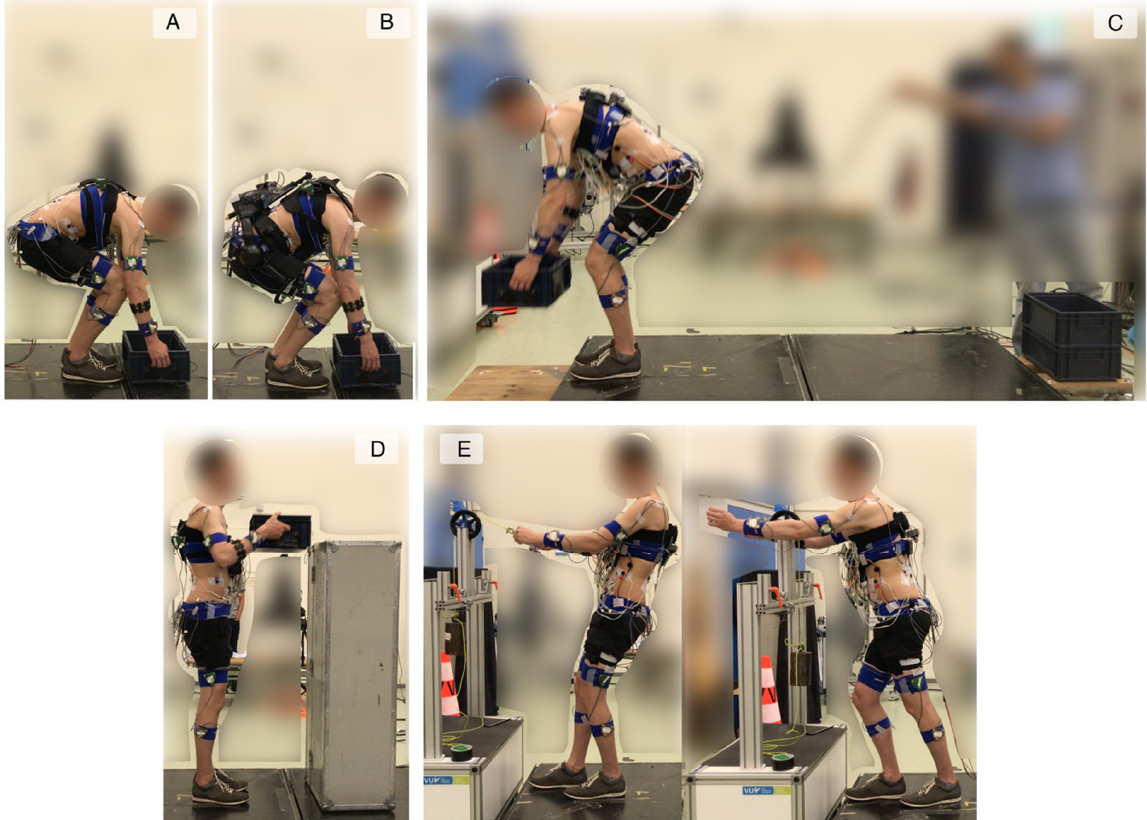
Figure 2. Participants performed different work-related tasks: ( A ) lifting from the ground without an exoskeleton, ( B) lifting from the ground with an exoskeleton, ( C ) box stacking, ( D ) lifting from a shelf, and ( E ) pulling and pushing.